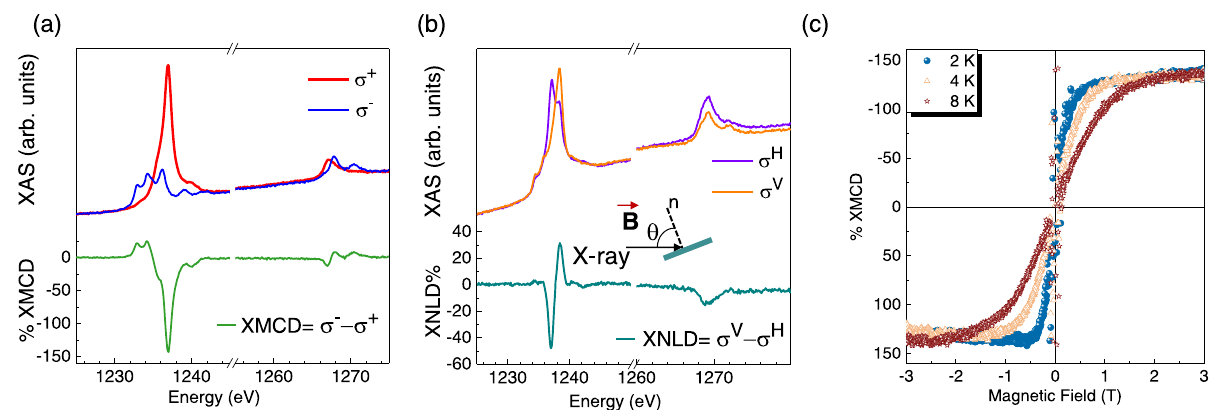
Fig. 2 Magnetic characterisation of the TbPc 2 monolayer on Pb(111). a XAS and XMCD spectra recorded at θ = 0°, 2 K and 3 T. b XAS and XNLD spectra recorded at θ = 45°, 2 K and 3 T. The inset depicts the detection geometry having the X-ray beam axis and applied magnetic fi eld oriented at an angle θ from the sample ’ s surface normal, n. c Magnetic hysteresis loop recorded at θ = 0° and at different